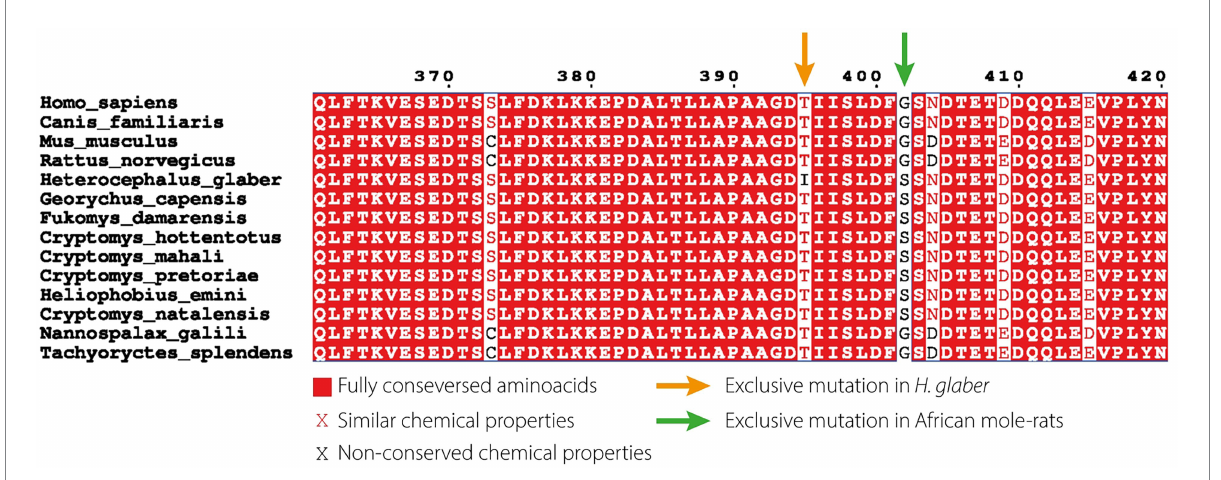
FIGURE 3 Conservation of HIF1 α amongst African mole-rat and other subterranean rodents. The naked mole-rat ( H. glaber ) presents a unique mutation (T395I) that presumably prevents being targeted for degradation. Alignment generated with ENDscript2 (Robert and Gouet, 2014) using data from Eigenbrod et al.